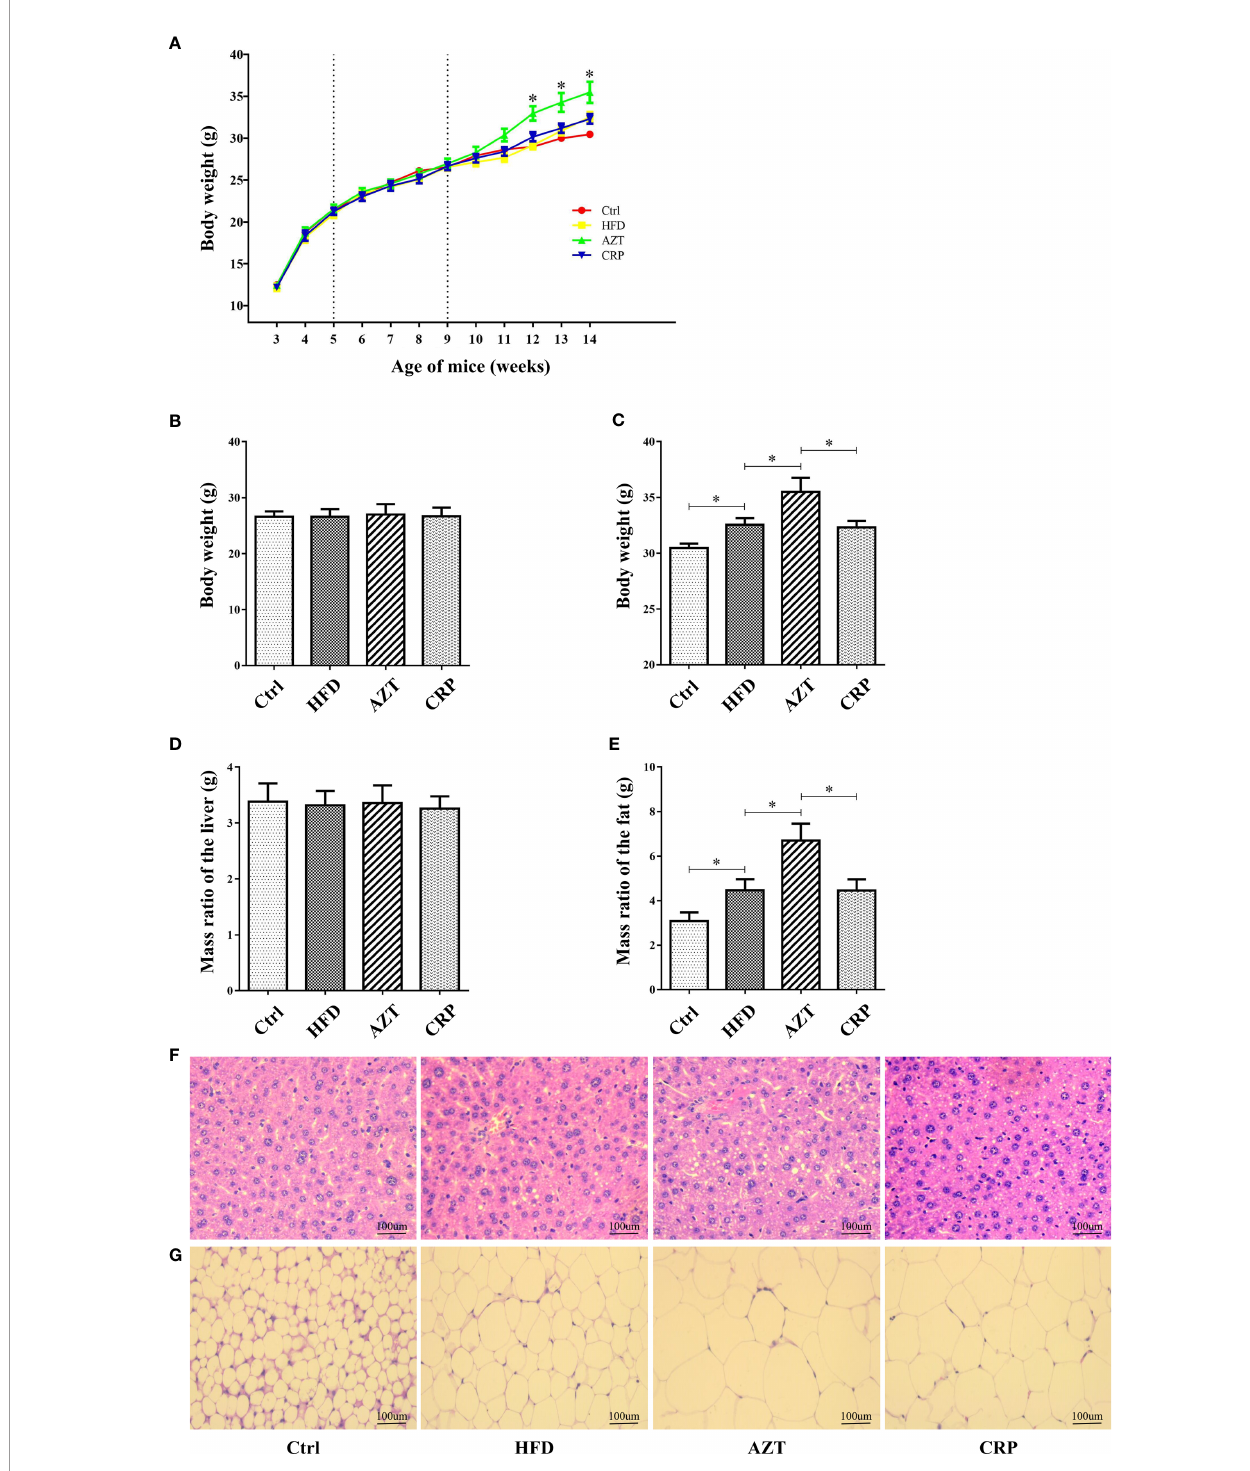
FIGURE 3 | Phenotypic changes between the groups. (A) Changes in body weight throughout the experiment. (B) Changes in body weight in nine-week-old mice. (C) Changes in body weight in 14-week-old mice. (D) The ratio of adipose tissue to body weight. (E) The ratio of liver to body weight. (F) H&E staining of liver. (G) H&E staining of adipose tissue. (200×, scale bar, 100 µm). Differences were assessed by ANOVA. Data are expressed as the mean ± SEM, n = 10 in each group. *P <